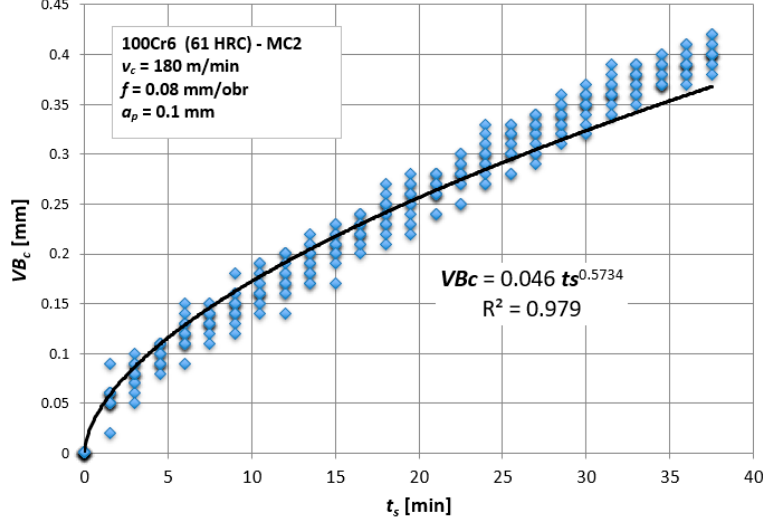
Figure 2. Tool wear, VB c , as a function of cutting time, t s , including all tests carried out.